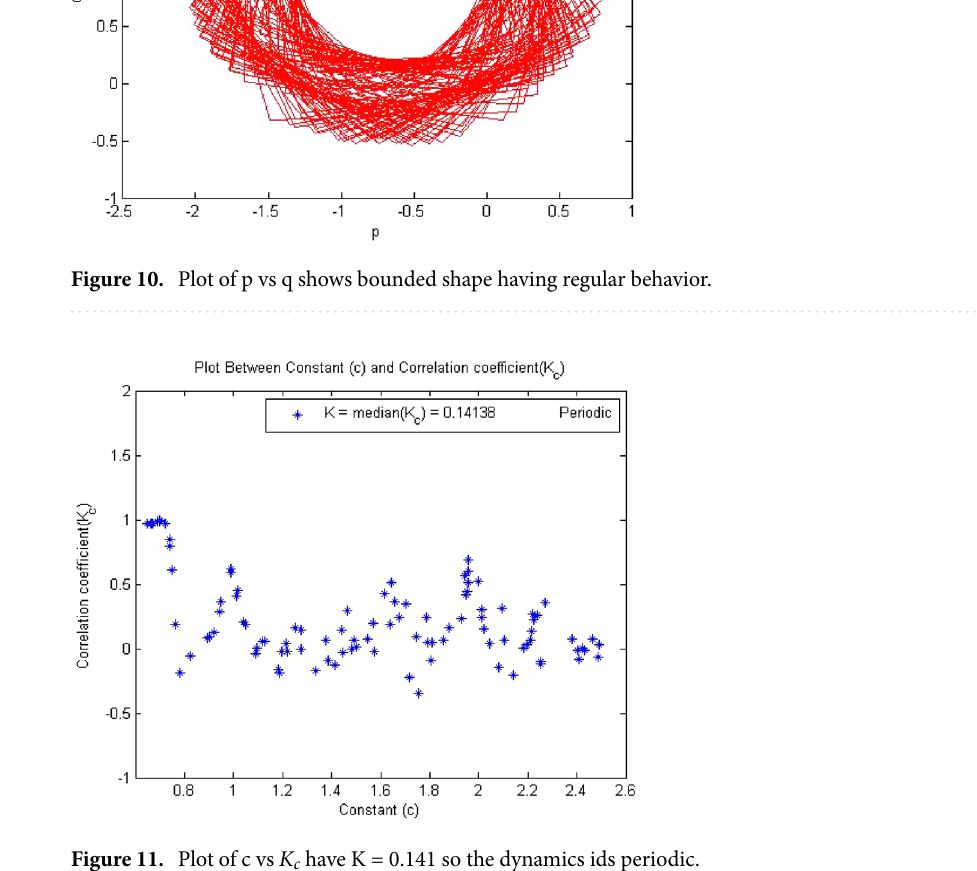
Figure 11. Plot of c vs K c have K = 0.141 so the dynamics ids